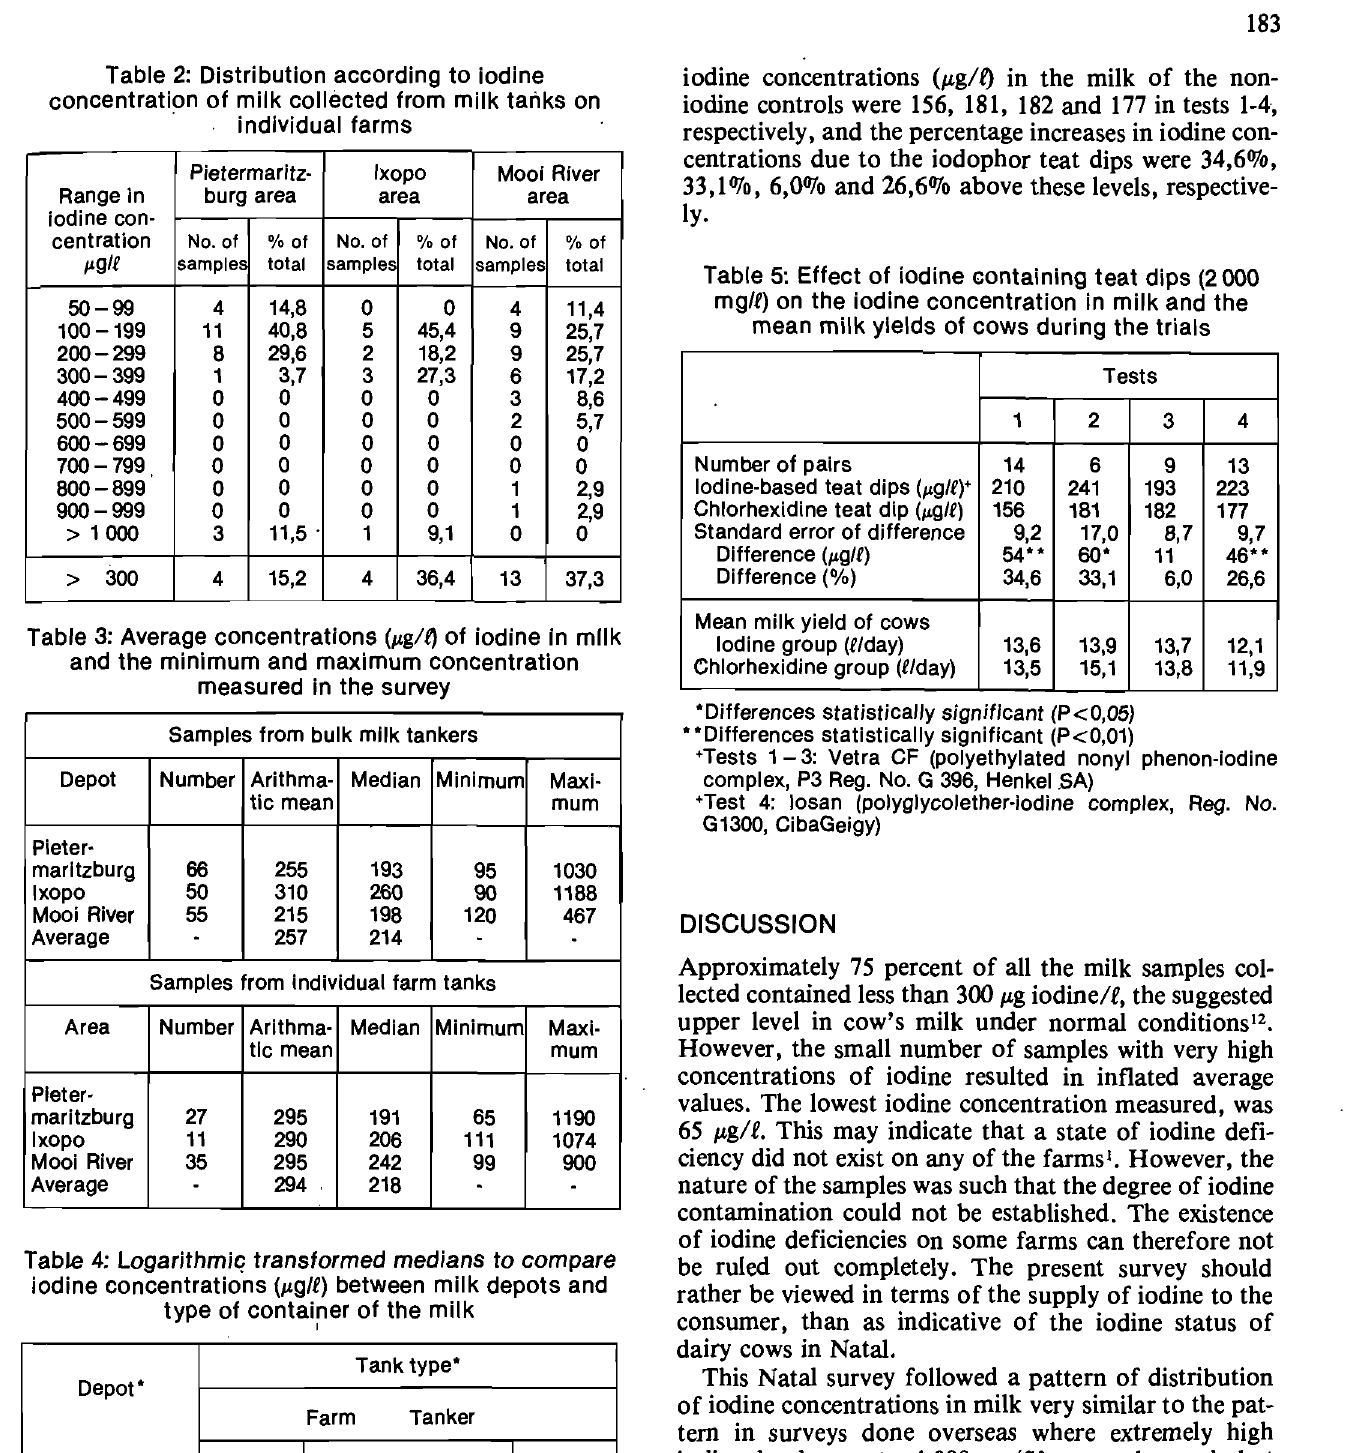
Table 5: Effect of iodine containing teat dips (2000 mg/f) on the iodine concentration in milk and